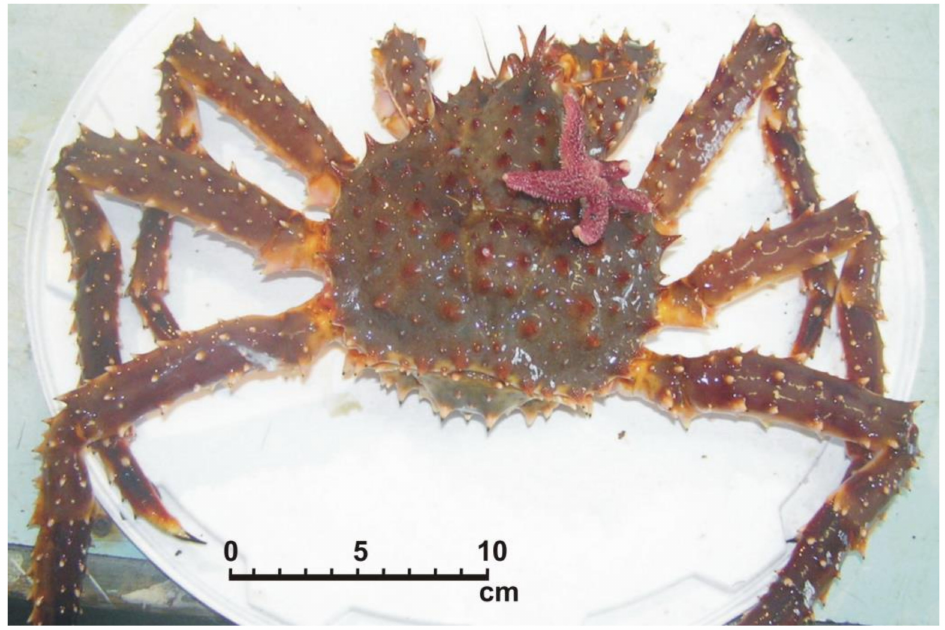
Figure 3. A specimen of the common starfish Asterias rubens on the carapace of a male red king crab Paralithodes camtschaticus . The starfish was removed from the host carapace. Weight of this epibiont was 42 g, arm length (AL) 29 mm. The second starfish specimen (weight 55 g, AL 34 mm) was registered on a male red king crab (new shell, CL 126 mm, weight 1194 g) collected in